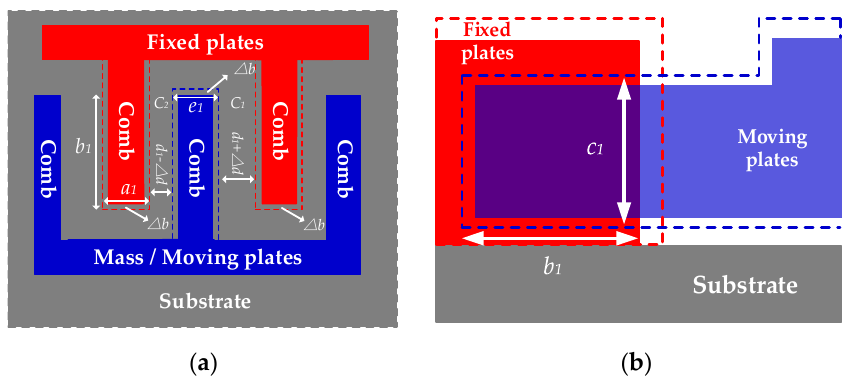
Figure 6. Deformation of the combs when